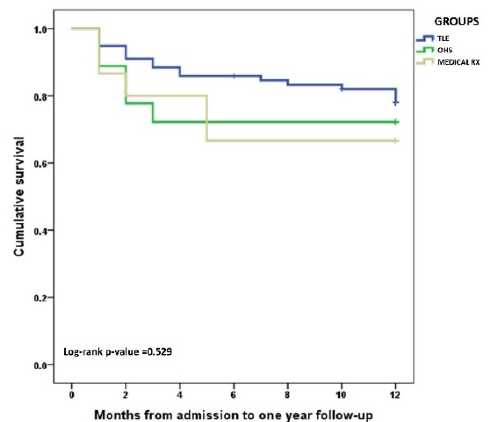
Figure 1. Kaplan–Meier curves describing survival probability, after one year of follow-up, according to the three therapeutic approaches used for CIED-related endocarditis: medical only, transvenous lead extraction (TLE), and open heart surgery